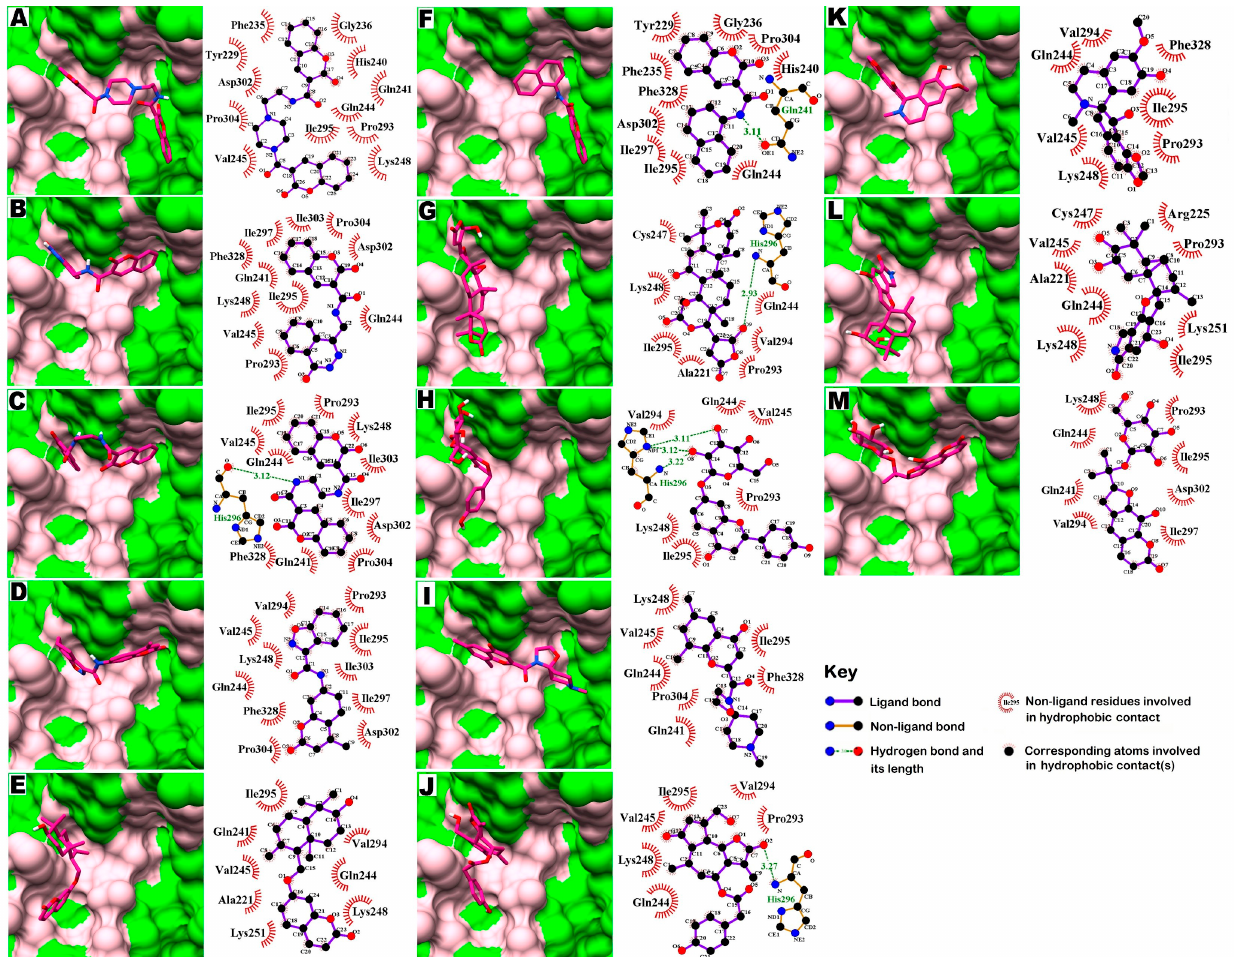
Figure 5. Molecular surface representation of EBOV-Z VP35 with respective ligands. ( A – M ) Molecular surface representation (in green) with respective ligands displayed in stick format (in magenta). Binding site residues are in pink. Alongside each 3D complex are schematic representations of the 2D interactions (with a cutoff distance of 4 Å) between each ligand and EBOV-Z VP35 amino acid residue using Ligplot analysis. Residues involved in hydrophobic contacts are black and demarcated by a spoked red arc, while those involved in hydrogen bonding are green, along with the values of the distances. Atoms are shown in white for carbon, red for oxygen, and blue for nitrogen.